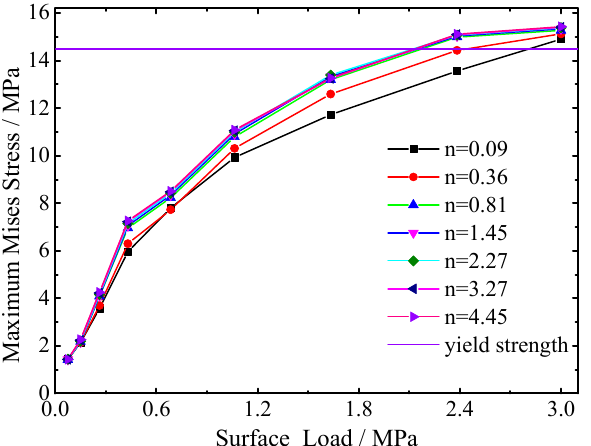
Figure 18. Maximum von Mises stress in HDPE pipeline with different defect lengths.